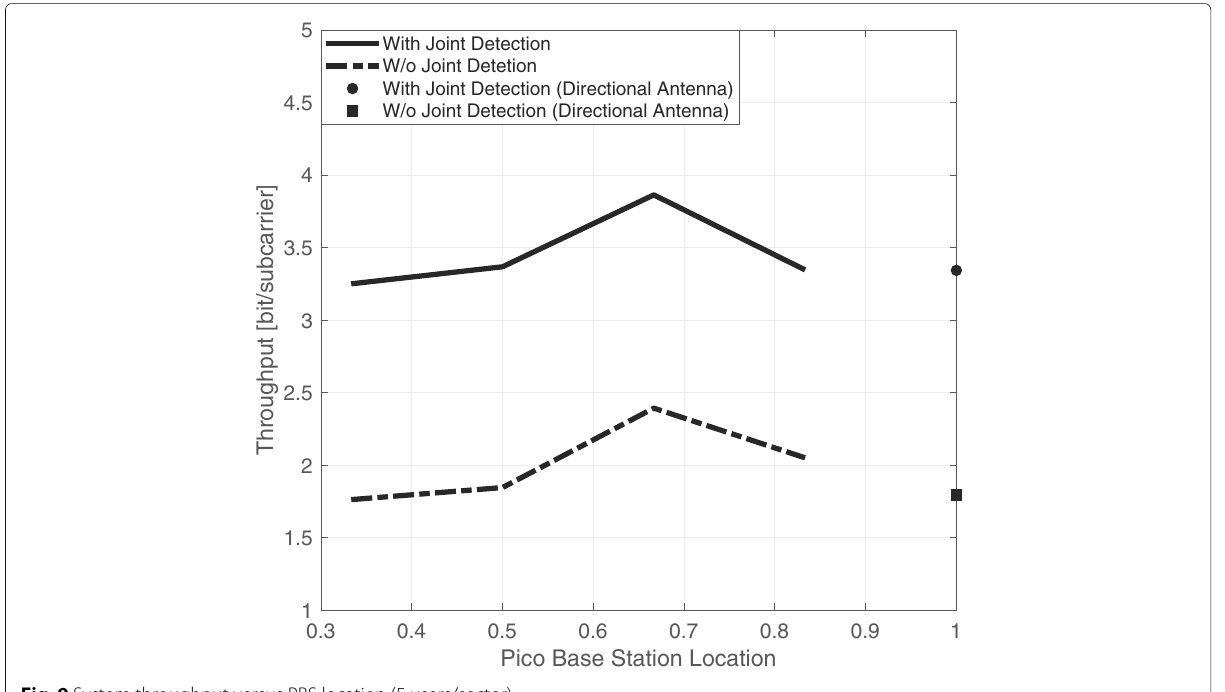
Fig. 9 System throughput versus PBS location (5 users/sector)